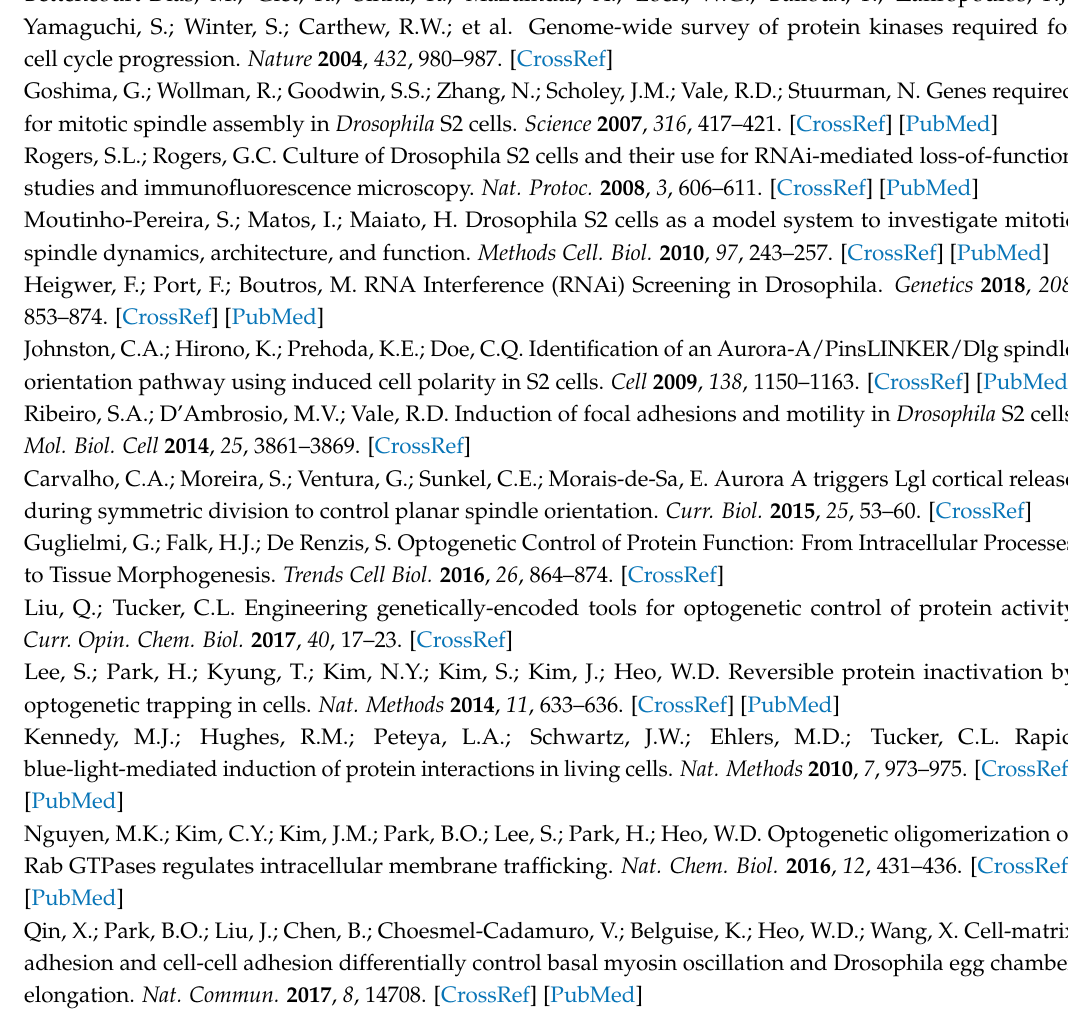
Figure A2. FLAG-tagged LARIAT clusters GFP. Drosophila S2 cells expressing GFP, CIBN-MP, and FLAG-CRY2-V H H incubated in the dark or exposed to a 472 nm LED light to stimulate clustering were stained for FLAG (magenta) to detect FLAG-CRY2.